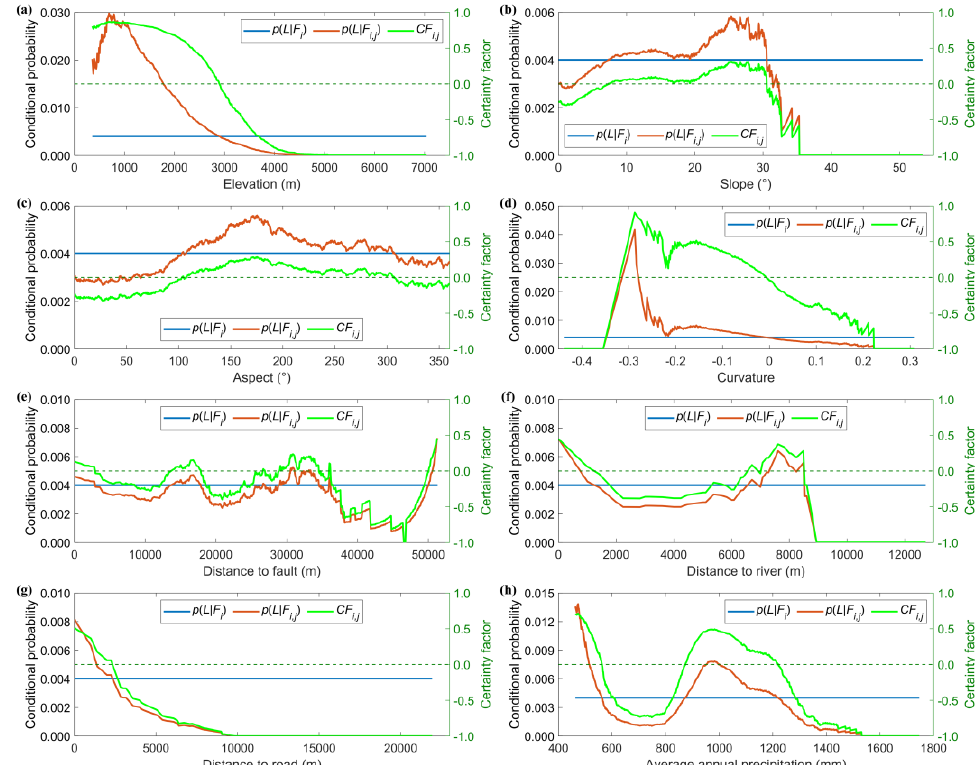
Figure 9. Variations in favorability value with factor values in the case study are shown using the certainty factor method. ( a ) Elevation. ( b ) Slope. ( c ) Aspect. ( d ) Curvature. ( e ) Distance to fault. ( f ) Distance to river. ( g ) Distance to road. ( h ) Average annual precipitation.